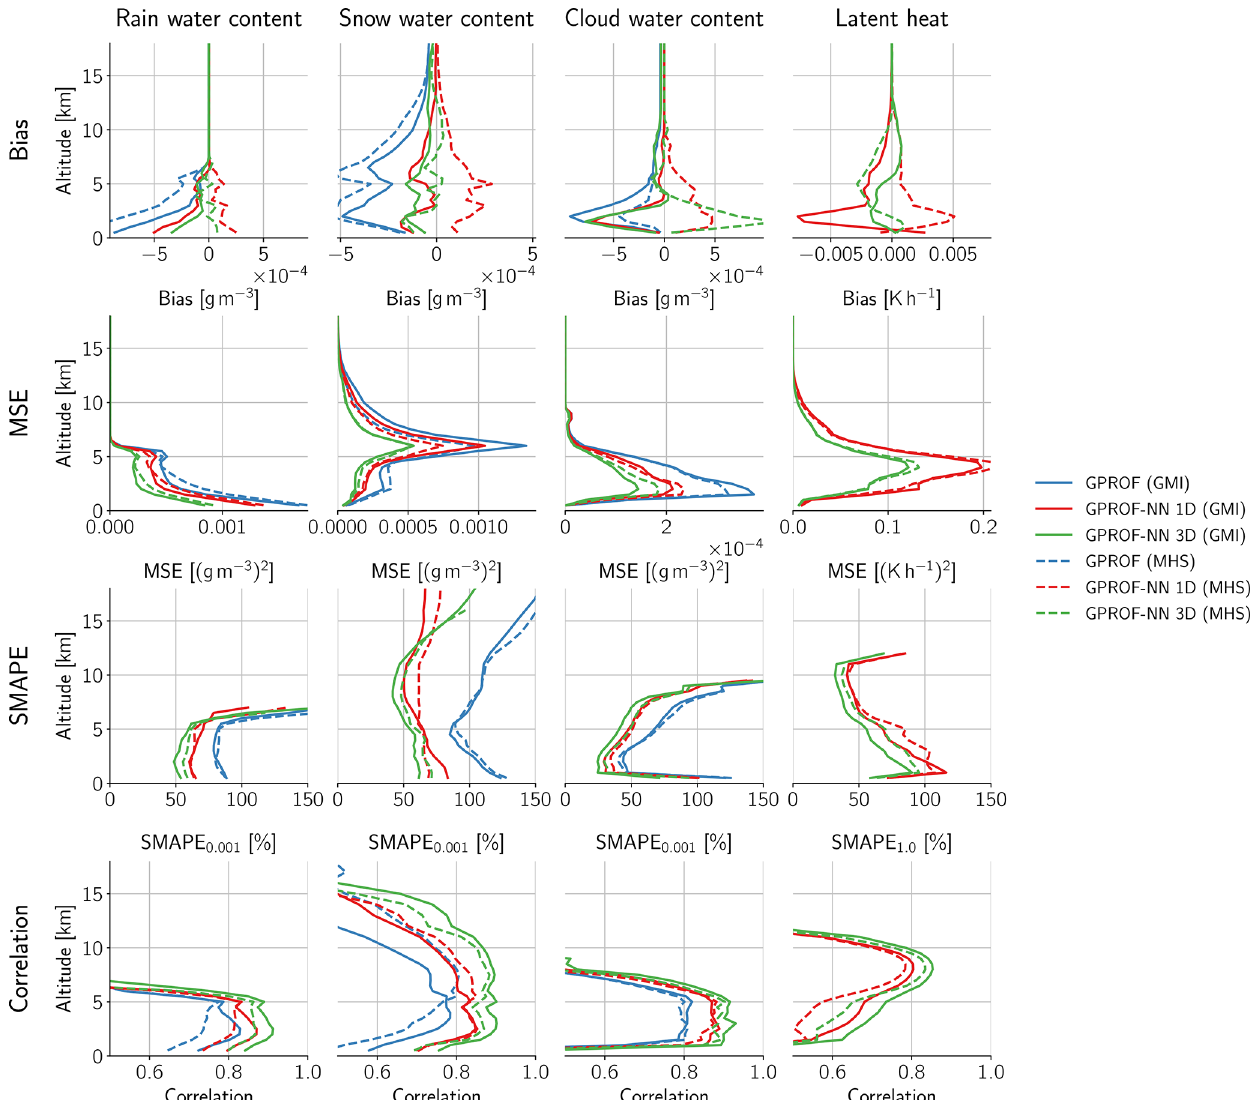
Figure 11. Error statistics of the retrieved profile variables. Columns show the errors for the different retrieved variables, whereas rows show altitude averaged bias, RMSE, SMAPE, and correlation, respectively.